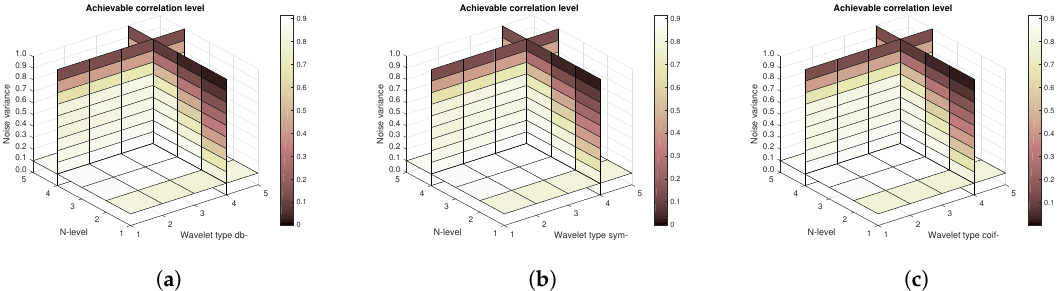
Figure 14. Mean achievable correlation levels for 15 CT images from 5 patients with use of three mother wavelet families – from left Daubechies ( a ), Symlet ( b ) and Coiflet ( c ).